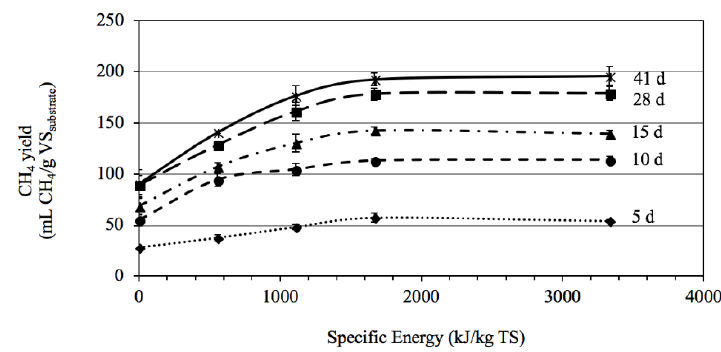
Figure 4. Methane yield of Napier grass silage (large size) at different levels of sonication pretreatment during 41-day digestion.